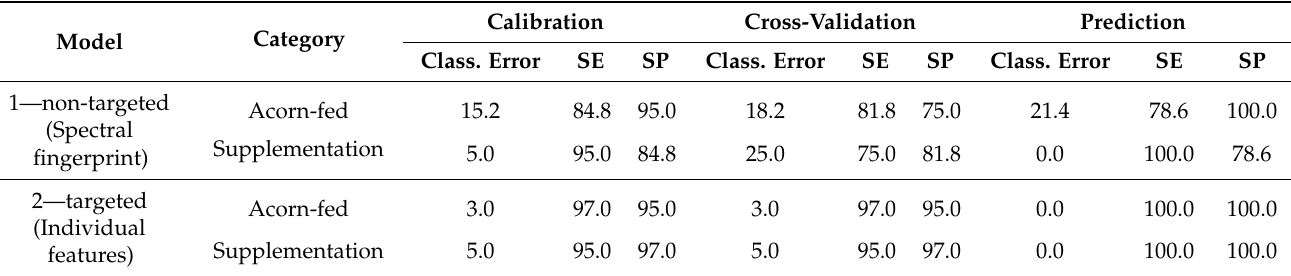
Table 3. Classification error, sensitivity and specificity percentages obtained for classification models